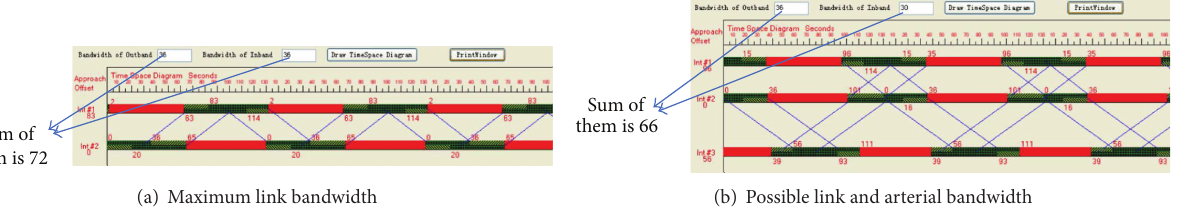
Figure 5: Example of maximum and possible link bandwidth and arterial